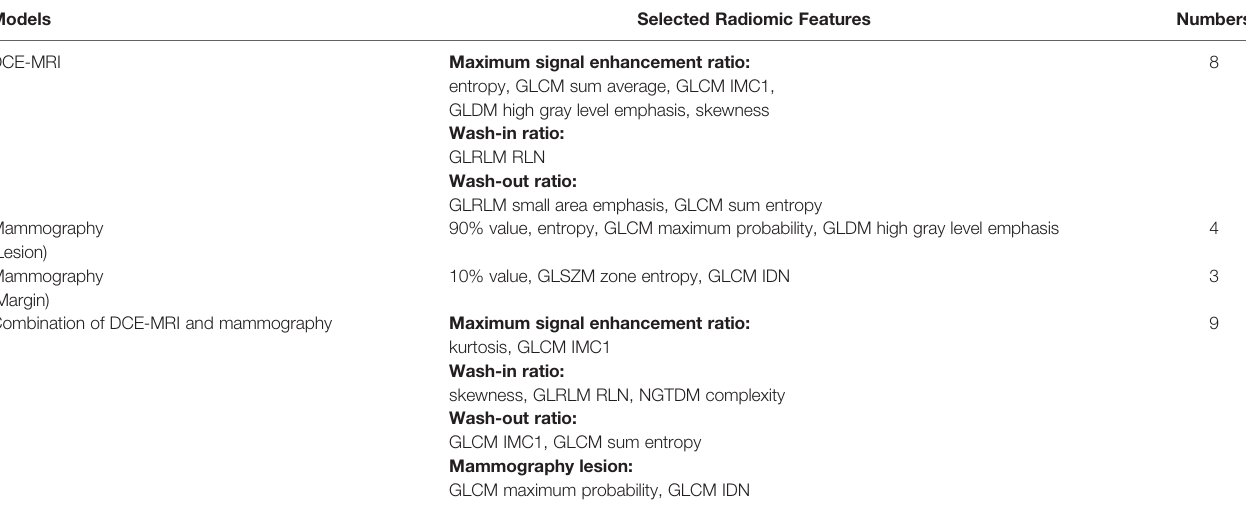
TABLE 2 | Selected radiomics features for modeling using MRI, mammography, and both combined. Models Selected Radiomic Features DCE-MRI Maximum signal enhancement ratio: